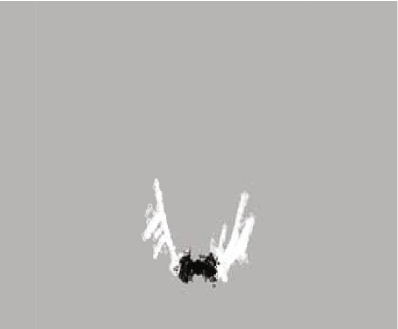
Figure 11: 300-mm borehole acoustic emission damage cloud map.